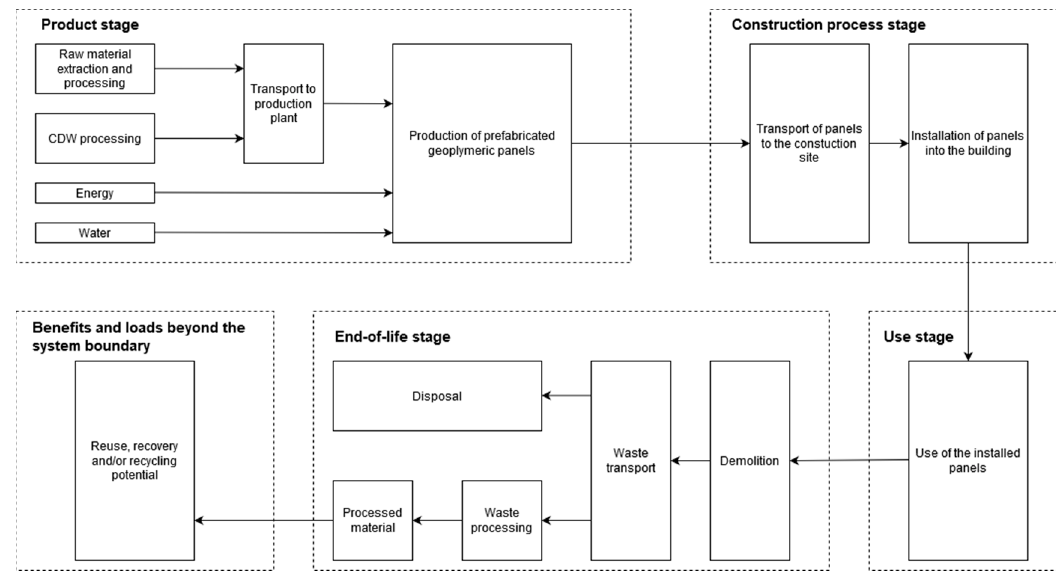
Figure 2. Schematic representation of the system boundaries (the figure was produced by the